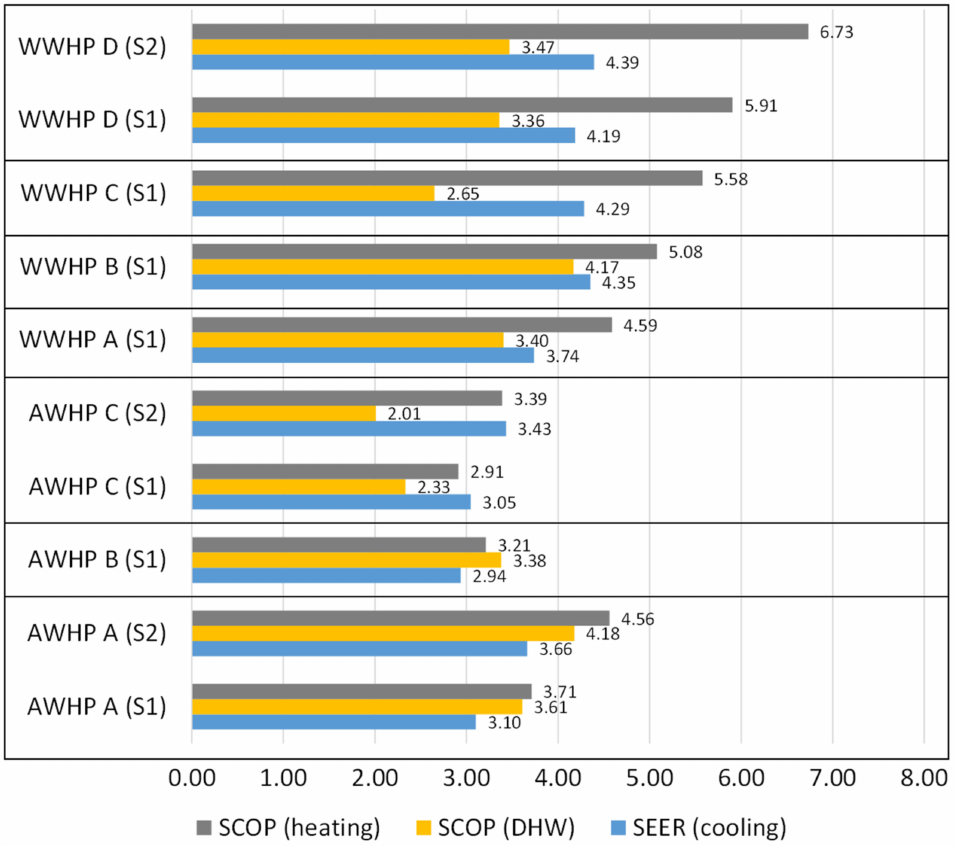
Figure 12. Seasonal efficiency indicators SCOP and SEER for AWHP and WWHP systems, calculated from simulation results for scenarios 1 and